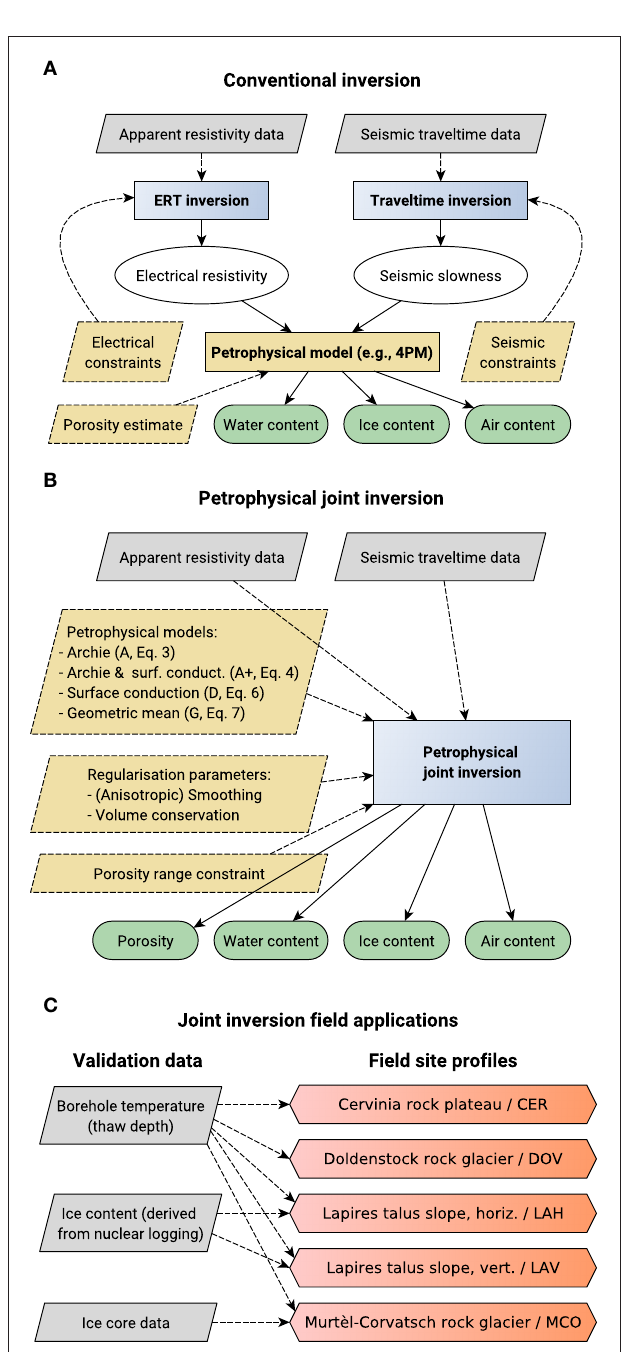
FIGURE 1 | Schematic on the estimation of water, ice, and air from electrical resistivity and refraction seismic data (modified after Wagner et al., 2019). (A) Conventional inversion of both datasets with subsequent petrophysical transformation. (B) Petrophysical joint inversion honoring both datasets and petrophysical relations during parameter estimation. (C) Field applications and validation data of this paper.